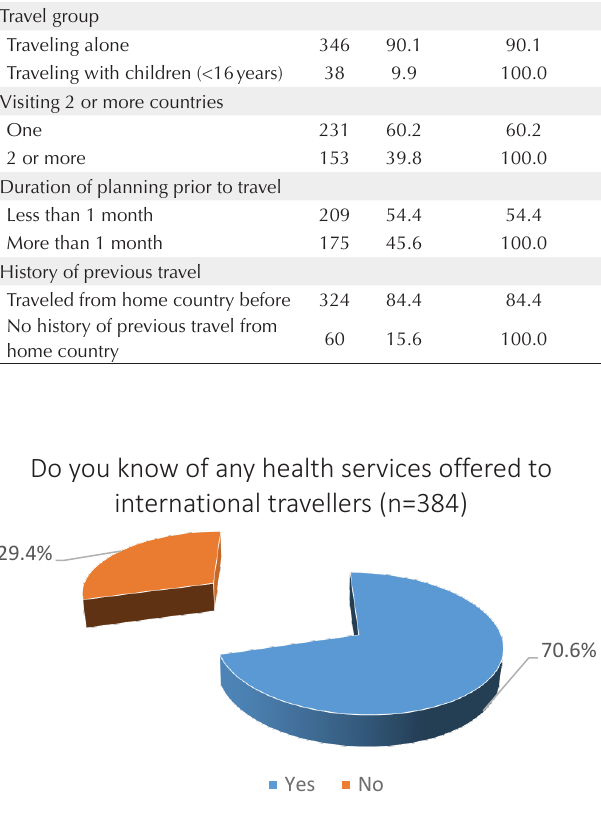
Figure 1. Services Offered to International Travelers That Were Known to Study